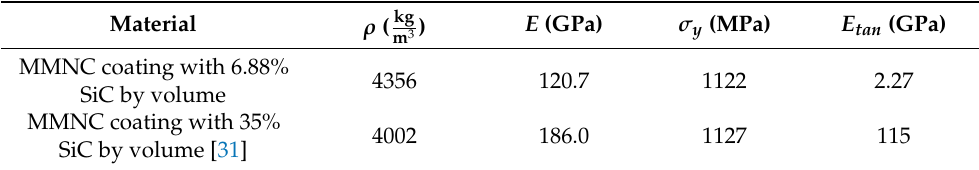
Table 8. Material model parameters of the Ti/SiC MMNC coating with 6.88% and 35% of SiC by